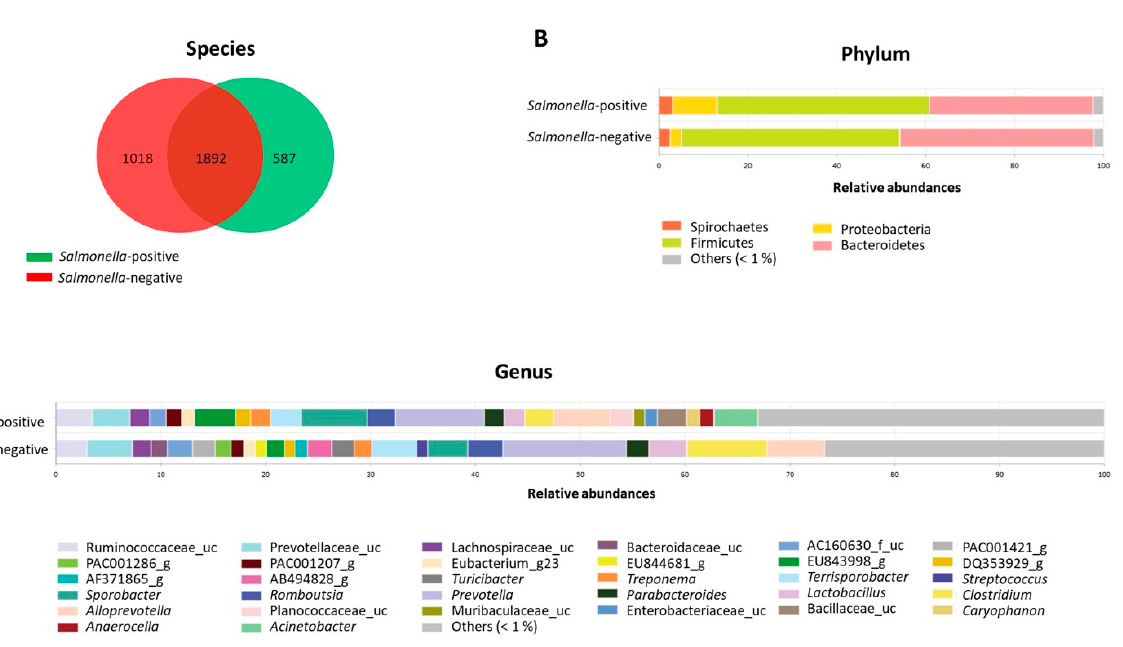
Figure 1. Microbial community comparisons between Salmonella -positive and -negative groups. ( A ) Venn diagram showing unique and shared species. ( B ) Relative abundance of bacterial phyla. ( C ) Relative abundance of bacterial genera. Table 4. Operational taxonomic units (OTUs)’ richness and alpha diversity indexes estimated in the gut microbiota of Salmonella -positive and Salmonella -negative pigs .